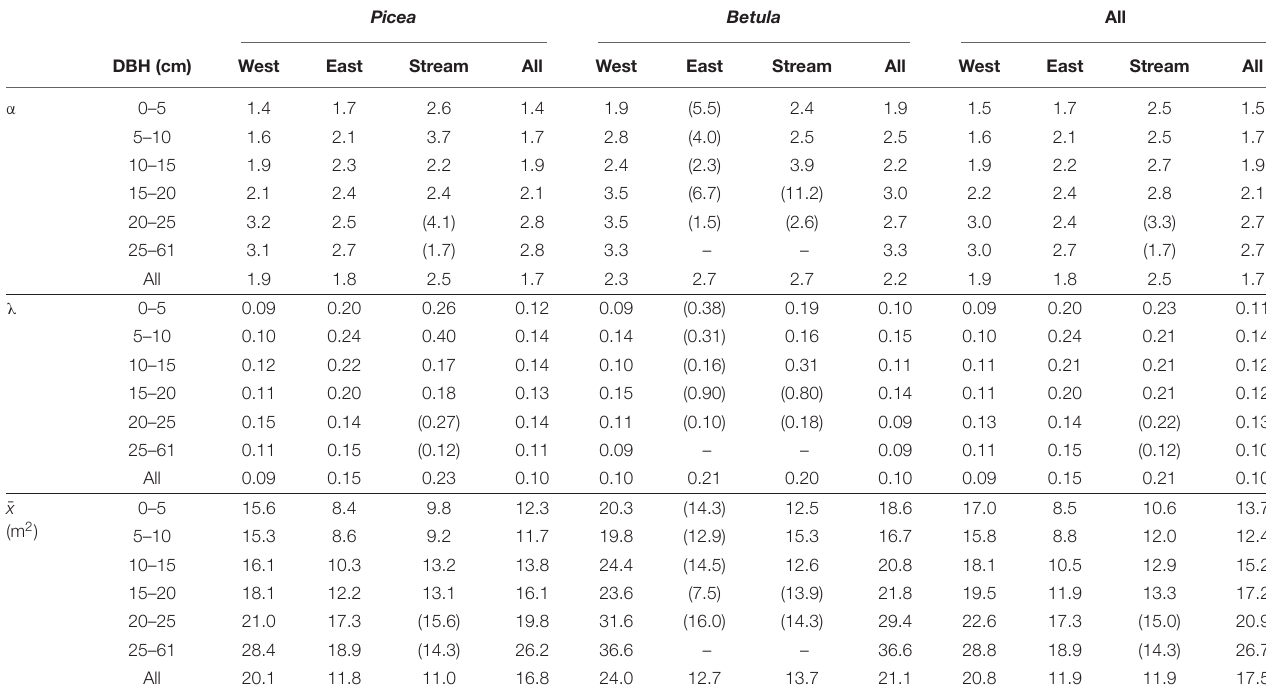
TABLE 2 | Shape ( α ) and rate ( λ ) parameters of the gamma distributions fitted for tree growing space (Voronoi polygon area) for trees by DBH class, species and subplot, as well as the corresponding observed means ( ¯ x ). Picea Betula All